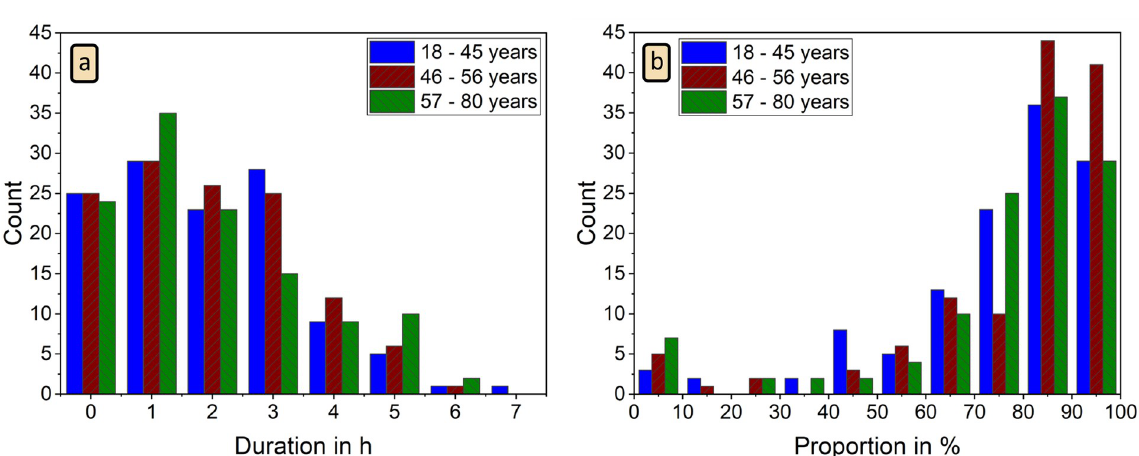
Fig 7. Histograms for total PWI duration and correctness of PWI identification. (a) Histogram of total duration of all detected PWI for each night; (b) histogram of fraction of correctly reconstructed and associated PWI (as compared to RRI from ECG) for each night. No clear differences between the three age groups (see Table 3) can be seen.